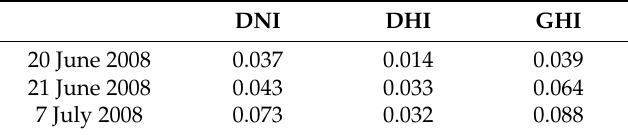
Table 1. Mean Absolute Error (MAE) in W/m 2 -nm of the simulated Direct Normal Irradiance (DNI), Diffuse Horizontal Irradiance (DHI) and Global Horizontal Irradiance (GHI). DNI DHI